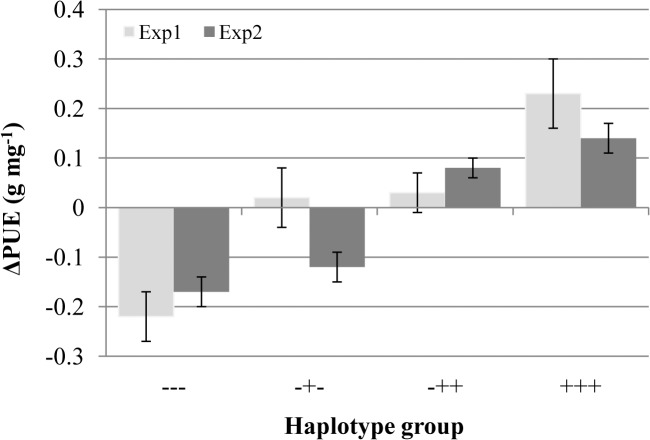
Deviation from the mean PUE for haplotype groups within the indica subpopulation.Labels on the x-axis (---,-+-, etc.) refer to having the negative or positive haplotype at each of the QTLs on chromosomes 1 (7.2Mb), 4 (17.8Mb) and 12 (26.6Mb), in that order (see Fig 3). Accessions in the ‘+++’ group include ‘Mudgo’, ‘Short Grain’ and ‘Yodanya’ while the ‘---‘ group are mostly older ‘modern’ varieties (IR8, Taichung Native, Teqing, Zhenshan2). The successful second generation green revolution varieties ‘IR36’ and ‘IR64’ belong to the ‘-+-’ group.